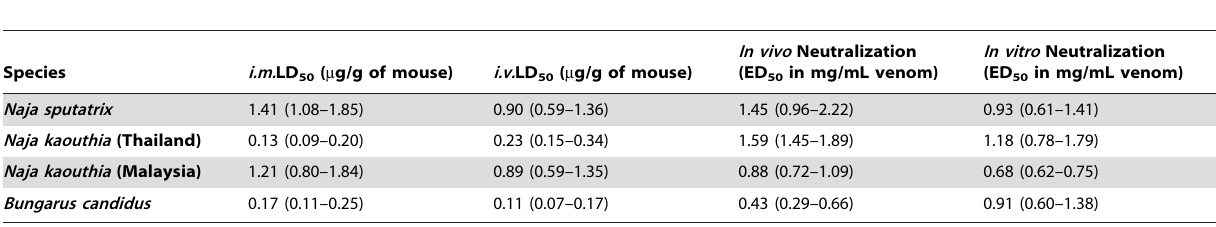
Table 3. In vivo neutralization of lethality of some cobra and krait venoms by NPAV.